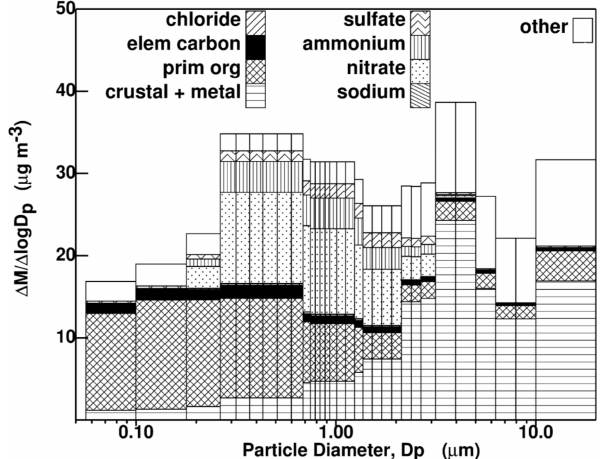
Fig. 3. Size distribution plot of the internal mixture particulate rep- resentation from 12:00 to 13:00LT on 24 December 2000 in Fresno, California. The 8 moving model size bins are mapped to 32 standard size bins to facilitate a comparison with source-oriented results in Fig.